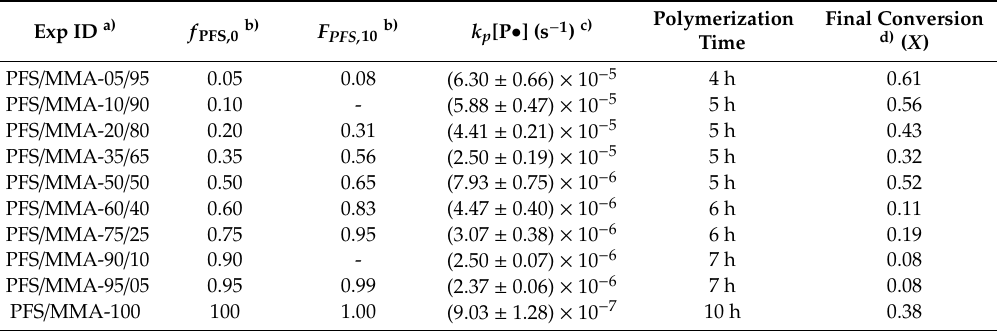
Table 2. 2,3,4,5,6-pentafluorostyrene / methyl methacrylate (PFS / MMA) random copolymerizations in 50 wt% xylenes solution at 90 ◦ C, using a MAMA-SG1